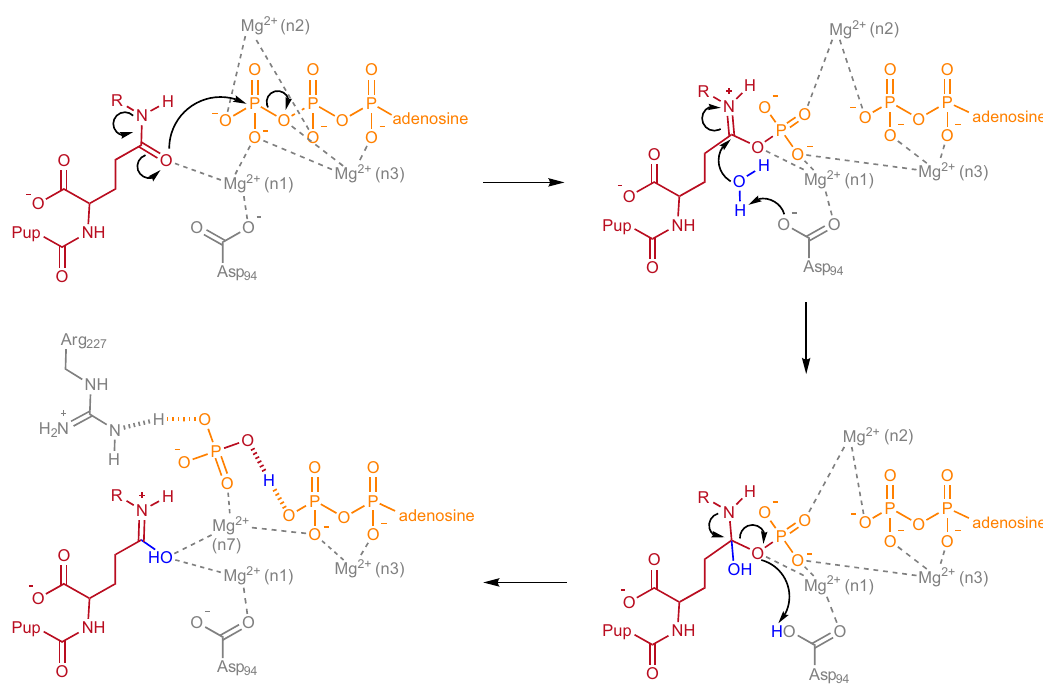
Fig. 6 Proposed mechanism for the generation of the catalytic Pi in the active site of Dop. Active site residues are numbered according to Acel Dop and shown in simpli fi ed representation omitting magnesium coordinating residues (Glu8, Glu10, Tyr92, Glu99, His155, and His241) and waters. Shared protons are bonded as hashed lines. R is equal to H or